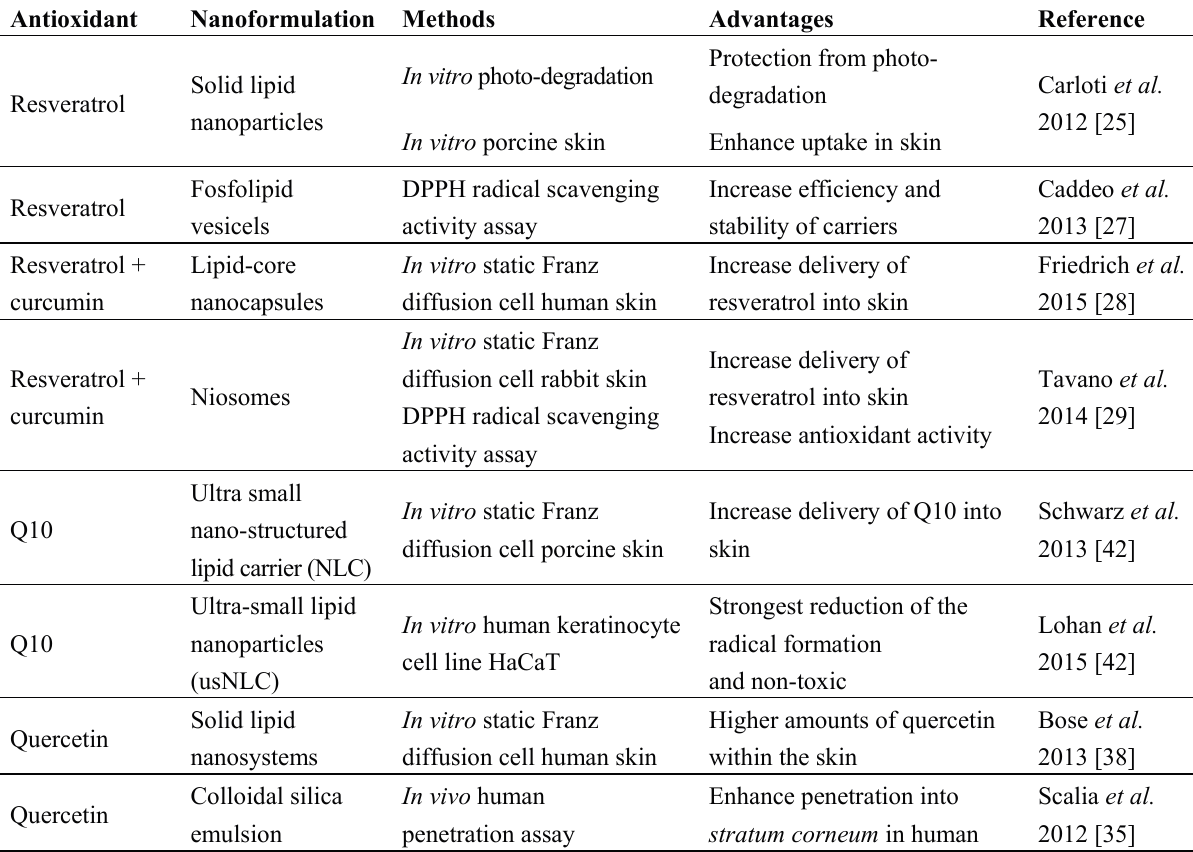
Table 1. Different nanoformulations that enhance the skin delivery of different antioxidants and other advantages demonstrated by different